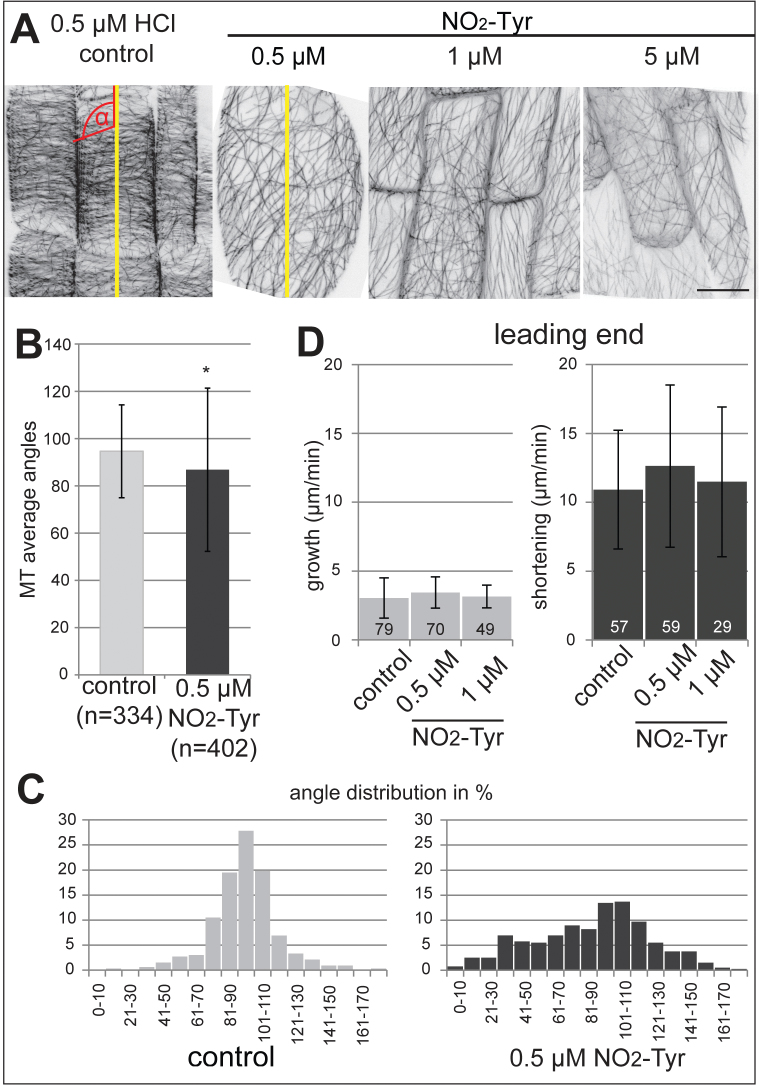
Organization of cortical microtubule (MT) arrays in epidermal cells at the elongation zone. (A) In controls, interphase cells show characteristic parallel alignment of cortical MTs. Low concentrations of 3-nitro-l-tyrosine (NO2-Tyr, 0.5 μM) disrupt the cortical MT array organization and cells show signs of non-polarized expansion. Representative, inverted images are maximum intensity z-projections of image stacks, taken at 1 μm z-intervals; stacks encompass optical sections from the surface to a median cross-section through the cells. The number of optical sections per stack varies. Scale bar=10 μm. (B–D) Distribution of MT angles and the dynamicity of MT plus (leading) ends in epidermal cells of the elongation zone; (B) MT angles (red angle symbol in A) were determined counter clockwise, relative to the long axis of the cell (indicated by the yellow lines in A). The average angle of MTs (86.8±34.6 °) in NO2-Tyr-treated cells differs significantly from the average angle in control cells (94.6±19.6 °). The total number (n) of evaluated MT angles is given. Results represent the average angle of n=8 cells calculated from eight plants for controls and the average angle calculated from n=7 cells of seven plants treated with 0.5 μM NO2-Tyr. The average angle of cortical MTs upon NO2-Tyr treatment is significantly different from the transverse angle observed in controls (*P=0.0003). It is noteworthy that the standard deviation is rather large for NO2-Tyr. (C) Distribution histogram of MT angles observed in relation to the long axis of the cell in (A); the x-axis represents MT angles in 10 ° bins and the y-axis depicts the frequency of measurements for each bin. (D) Growth (polymerization) and shortening (depolymerization) velocities were determined for MT plus (leading) ends. No significant differences in MT dynamicity were observed between no treatment controls and NO2-Tyr-treated cells. MT growth and shortening velocities were measured in controls (n=23 cells from 10 roots), 0.5 μM NO2-Tyr-treated (n=28 cells from 11 roots), and 1 μM NO2-Tyr-treated (n=21 cells from eight roots) plants. The numbers of analysed plus ends are indicated in the bar diagram. Results represent the average velocities of two independent experiments. Error bars indicate ±standard deviation.